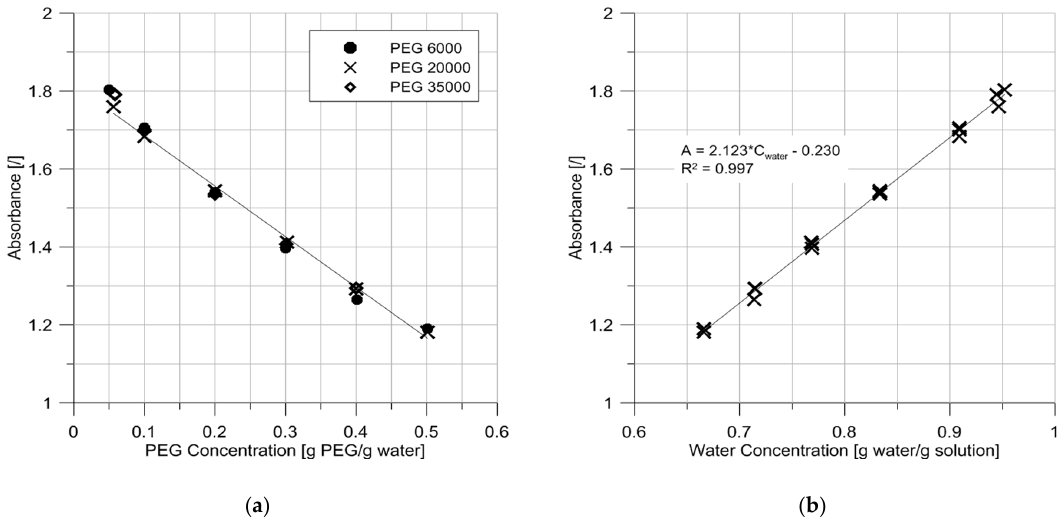
Figure 4. ( a ) Evolution of absorbance with PEG concentration for three different PEG molecular masses; ( b ) Evolution of absorbance with water concentration (no distinction of PEG types). Tests were performed at 20.5 degrees Celsius.